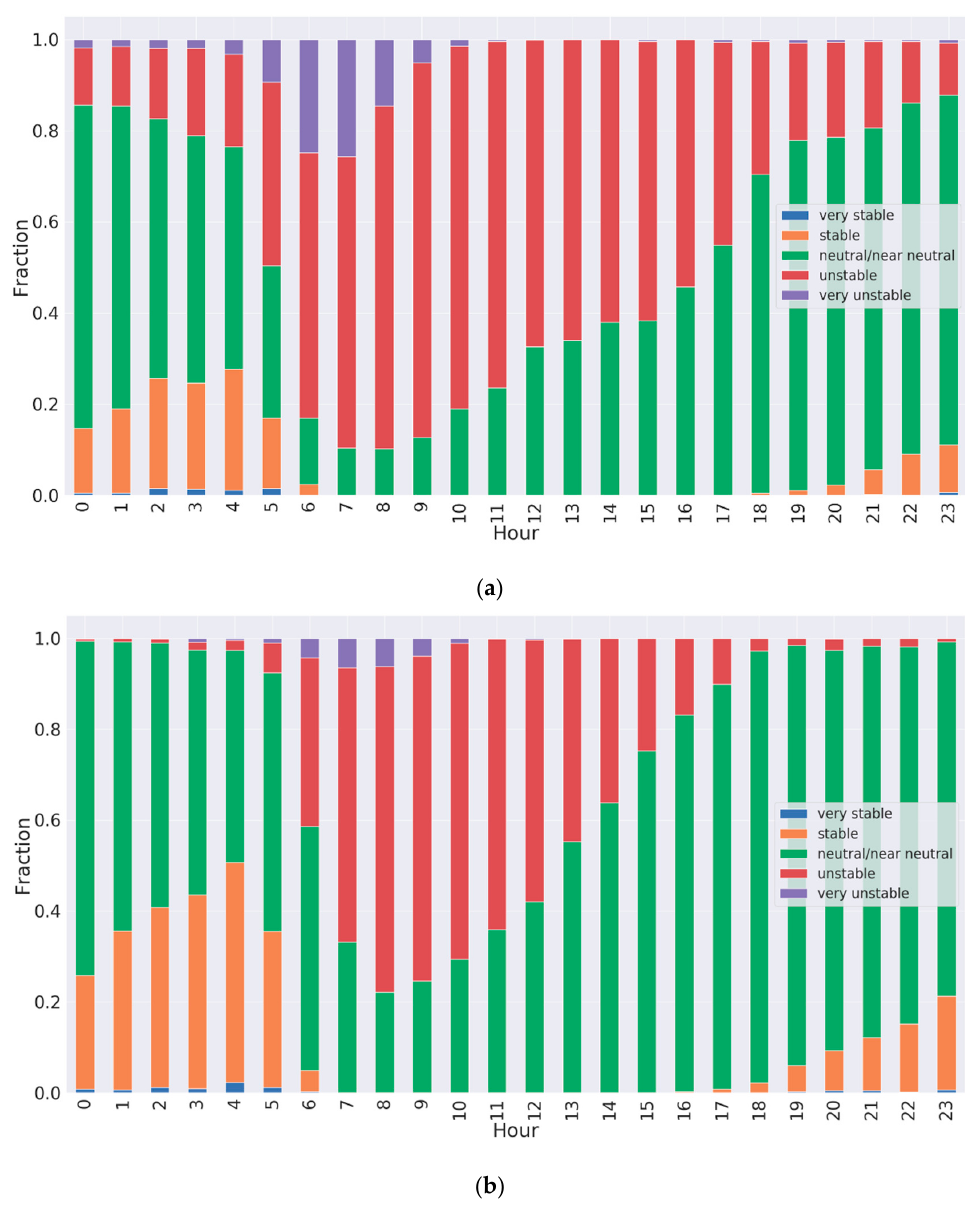
Figure 8. The hourly distribution of the atmospheric stability at the ( a ) Z2–Kiryat Motzkin and ( b ) C9–Tel Hai elementary school, Haifa weather stations. All time points are in LST (UTC+2).